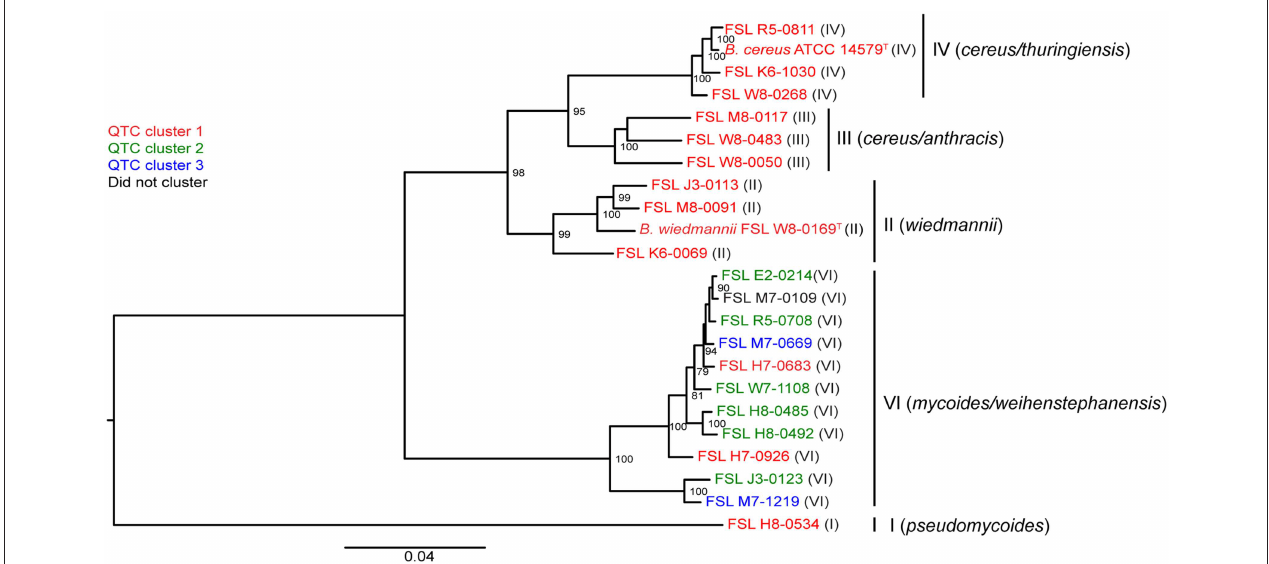
FIGURE 3 | Phylogenetic tree constructed from the core SNPs identified in the genomes of 23 B. cereus isolates. The maximum likelihood tree was constructed using a general time-reversible (GTR) model with gamma-distributed sites and 1,000 bootstrap repetitions. Roman numerals in parentheses represent the phylogenetic clade of the isolate, as defined previously (Kovac et al., 2016). QTC clusters representing isolates with similar growth patterns in BHI and SMB at 6 ◦ C (see Figure 1A ) are mapped onto the phylogenetic tree. Isolates shown in red represent QTC cluster 1 isolates (non-psychrotolerant in BHI broth or SMB). Isolates shown in green represent QTC cluster 2 isolates (psychrotolerant in BHI broth but not SMB), and isolates shown in blue represent clade 3 isolates (psychrotolerant in both BHI broth and SMB). One isolate (FSL M7-0109) did not cluster with other isolates, and is therefore shown in black font. Numbers at branch points represent bootstrap values; only bootstrap values > 70 are